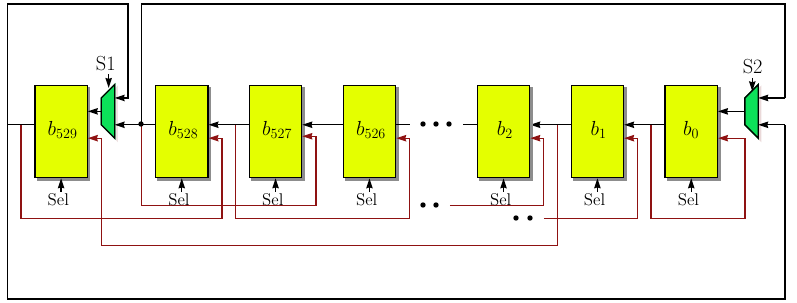
Figure 11: 2nd Circuit for Knuth